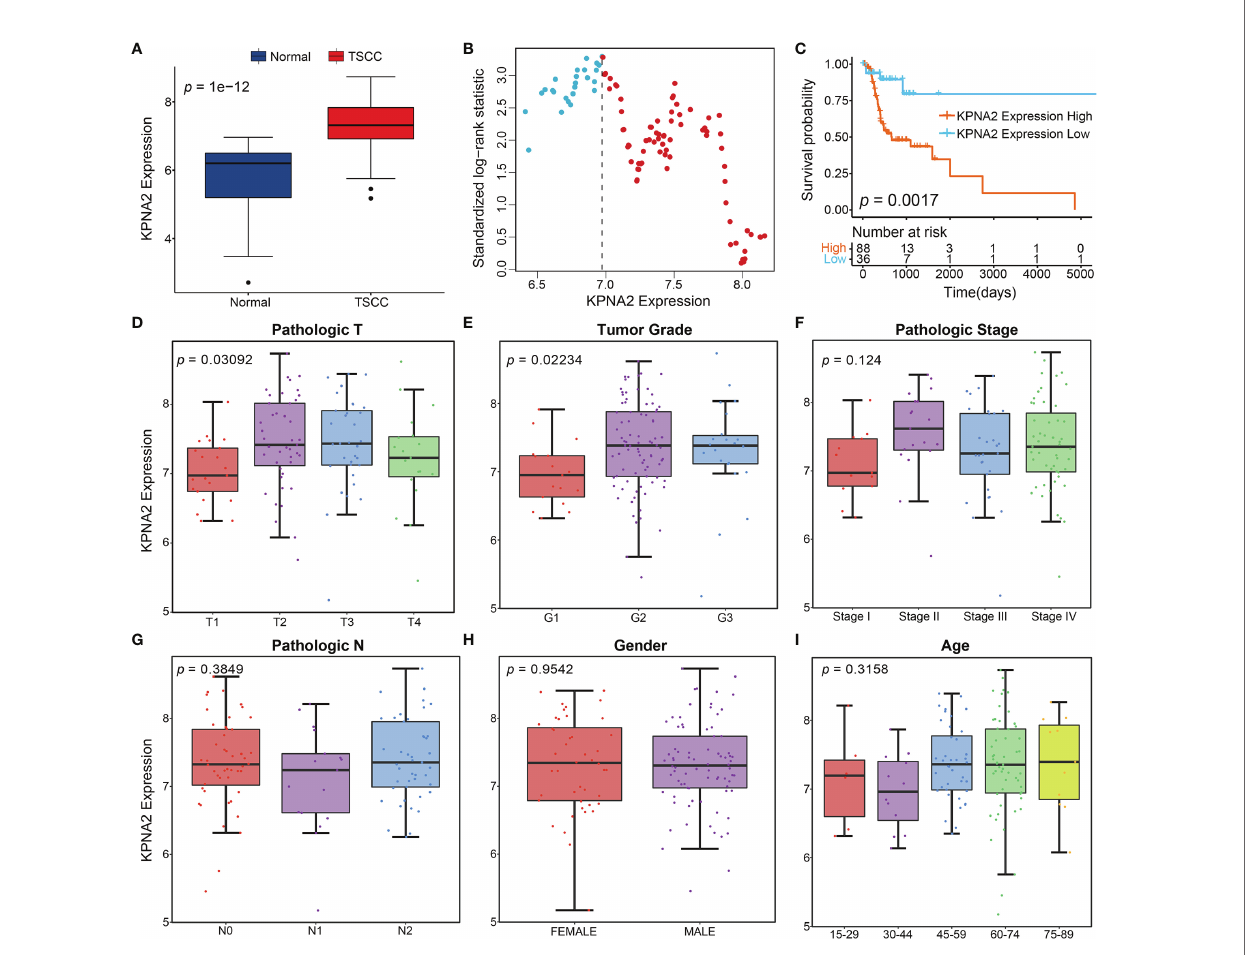
FIGURE 1 | Association between KPNA2 expression and clinicopathological features of TSCC and diagnostic signi fi cance of KPNA2. (A) Cancer status. (B) Scatter plots show normalized log-rank statistical values for each respective cut-off of KPNA2 expression values. The vertical dashed line marks the best cut-off value with the most signi fi cant standard logarithmic rank statistic. (C) Kaplan-Meier plot for overall survival outcomes of TCGA-TSCC patients categorized based on KPNA2 expression. (D) Tumor invasion depth. (E) Tumor grade. (F) Stage. (G) Lymph node metastasis. (H) Gender. (I) Age. TABLE 1 | Relationship between KPNA2 expression and clinical characteristics of TSCC patients. All cases KPNA2 Low